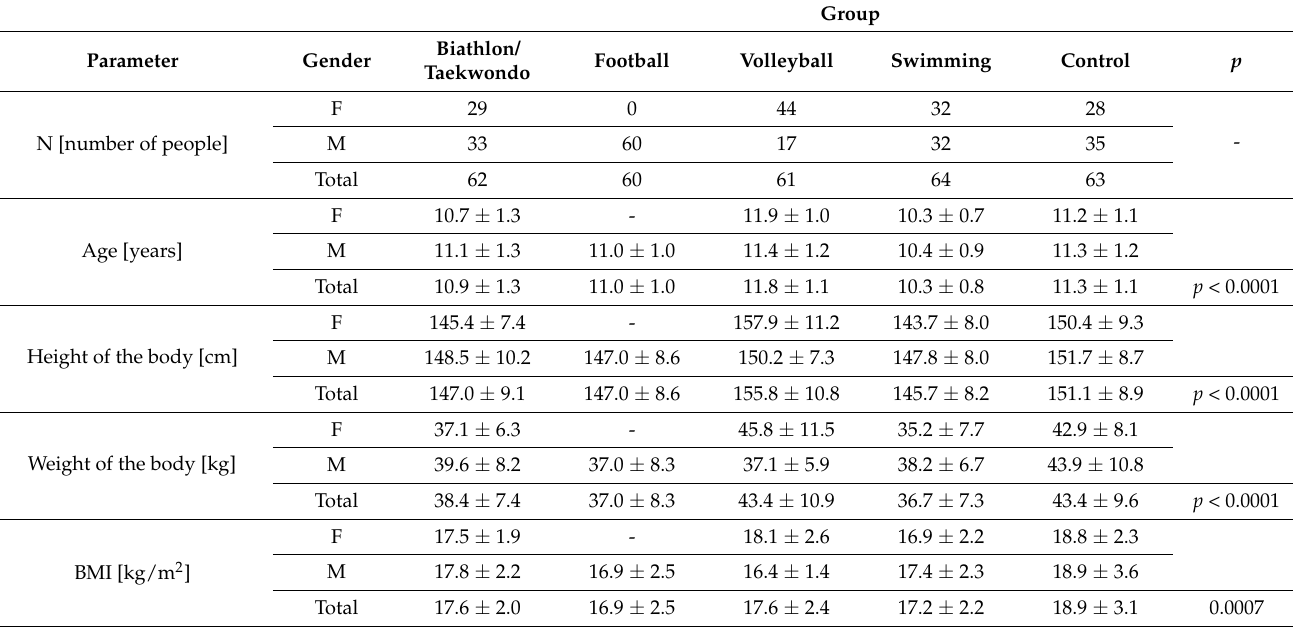
Table 1. Biometric data of the examined children.